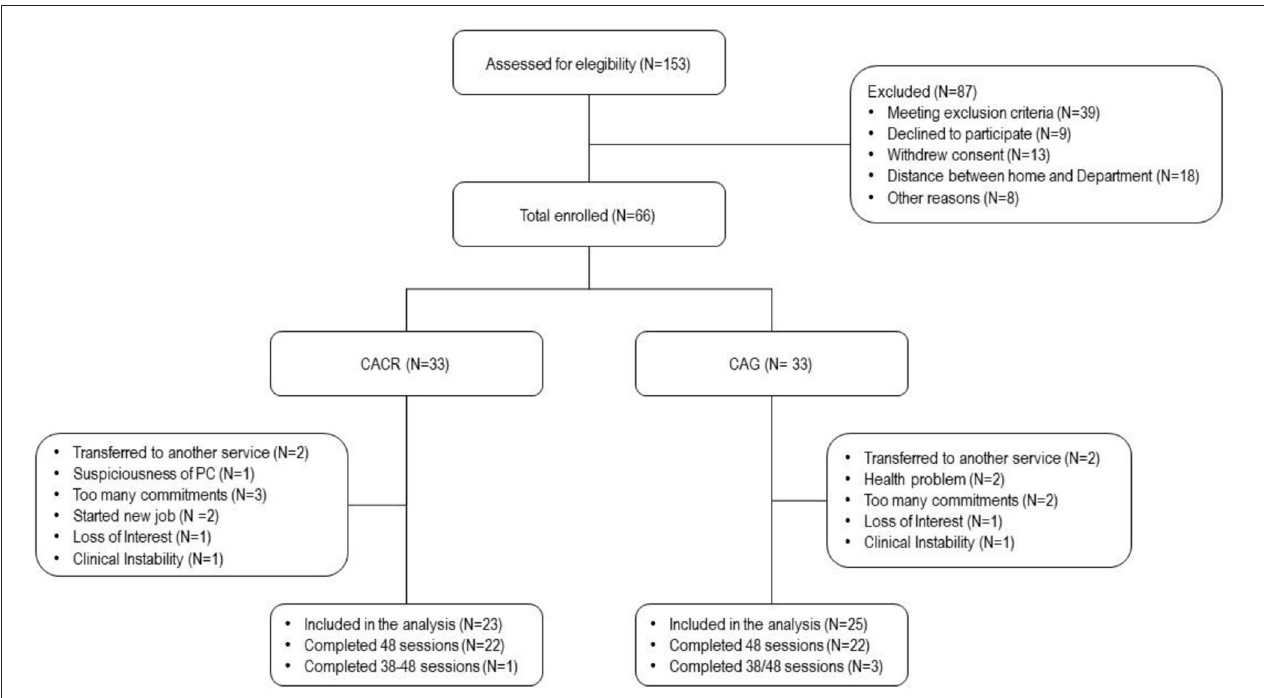
FIGURE 1 | Flow diagram of assessment for the eligibility in the two